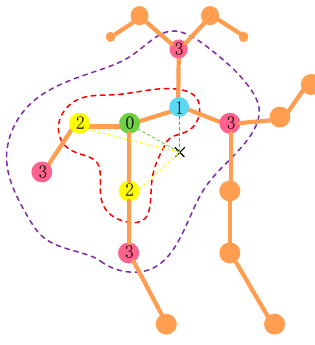
Figure 5. New partitioning strategy. The root node is represented by a green dot, the centripetal point is represented by a blue dot, the yellow dot represents a centrifugal dot, and the pink dot represents a point 2 from the root node.